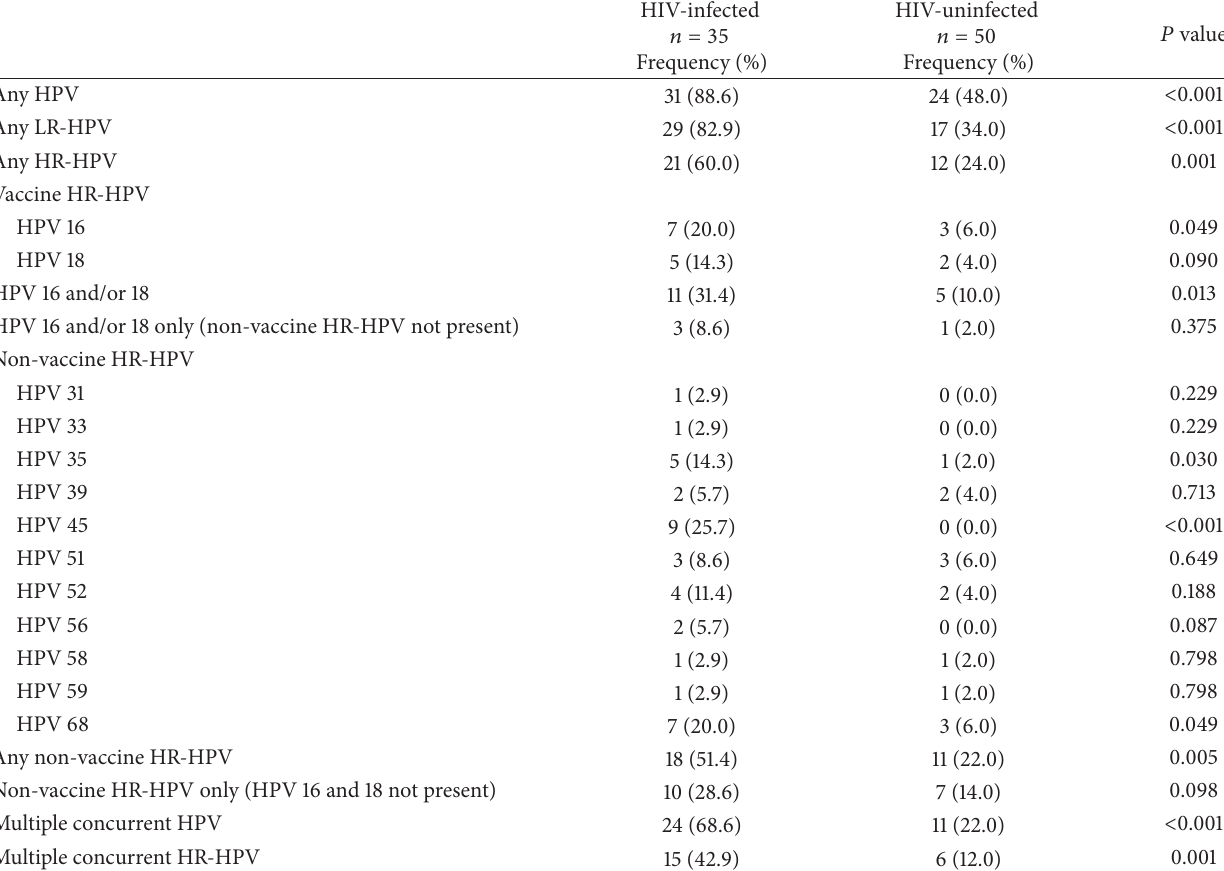
Table 2: Epidemiology of HPV by HIV